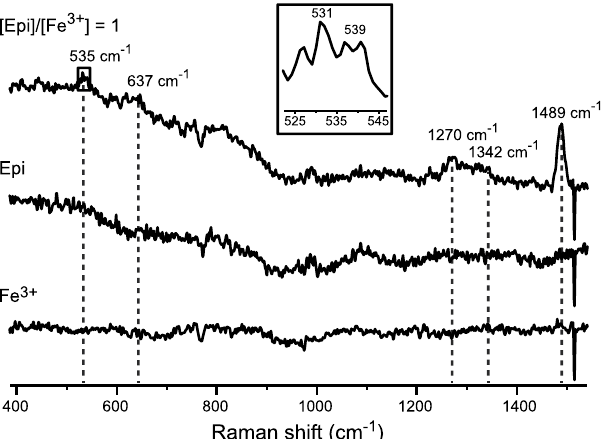
Figure 3. Raman spectra of 0.2 mM Epi with or without 0.2 mM Fe 3 + in 10 mM phosphate buffer, pH 7.4. The spectrum of 0.2 mM Fe 3 + is shown for comparison. Spectra were obtained after 15 min incubation period, using the λ = 532 nm laser excitation line. Inset: Two bands contributing to the signal at ∼ 535 cm -1